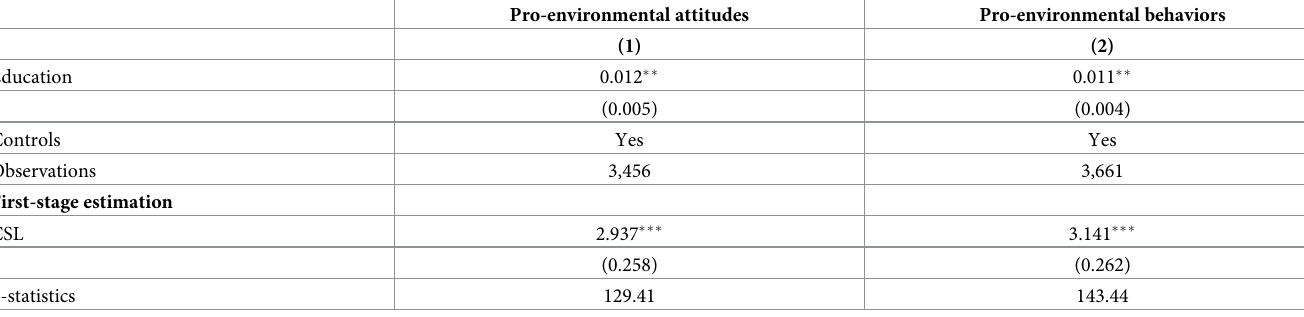
Table 4. The effects of education on pro-environmental attitudes and behaviors, 2SLS results.